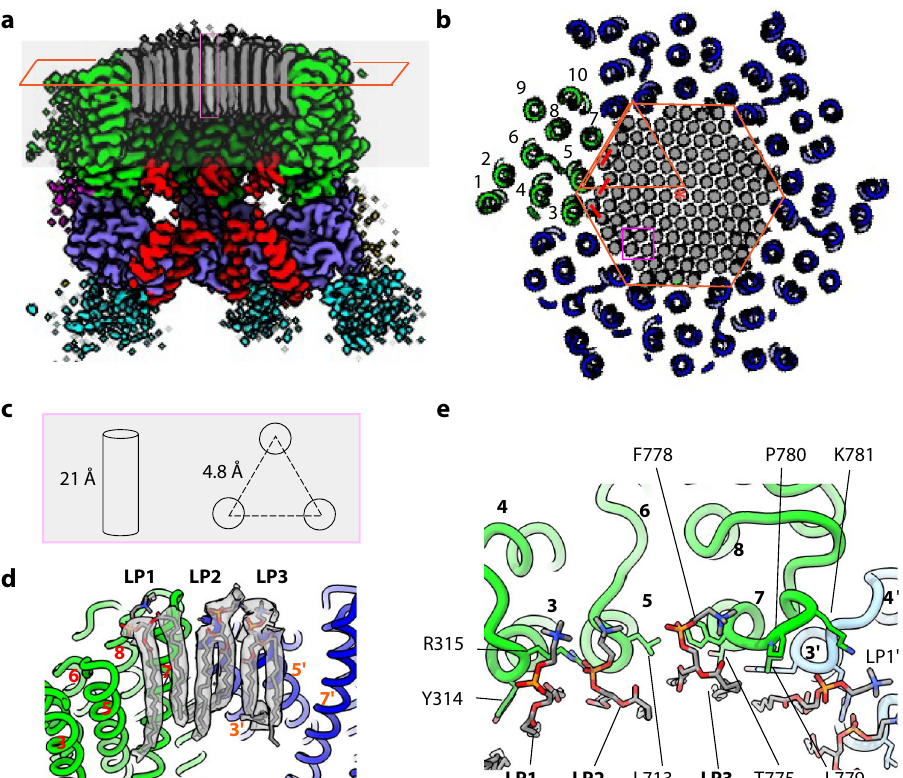
Fig. 2 Lipids in the central hole of the Pma1 hexamer. a Cut-in view parallel to the membrane shows the map of autoinhibited Pma1. The rod-like lipid densities are shown in gray. A single lipid tail density is highlighted by a magenta rectangle. b Cut-in view from exoplasmic side of the autoinhibited Pma1. The Pma1 hexamer is shown as a cartoon, and lipids are shown as densities. The orange hexagon indicates that the lipid densities are in 6-fold symmetry, and one copy was highlighted by a triangle. The center density is highlighted by a star. Three lipids interacting with one Pma1 protomer are highlighted by three red lines. Three neighboring densities are highlighted by a magenta rectangle. c Length and spacing distance of the rod-like lipid tail densities. d Cryo- EM densities of three lipids located next to Pma1. e Interactions between three lipids (LP1, LP2, and LP3) and Pma1. Key residues and lipids are shown as